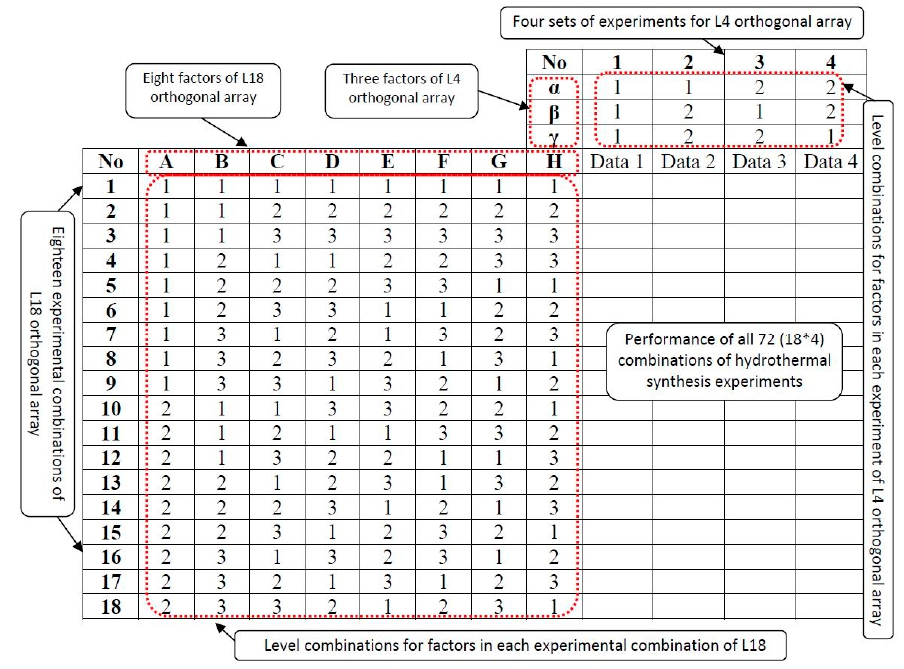
Figure 1. In this study, L18 as the inner array and L4 as the outer array were used for hydrothermally synthesized smectites.